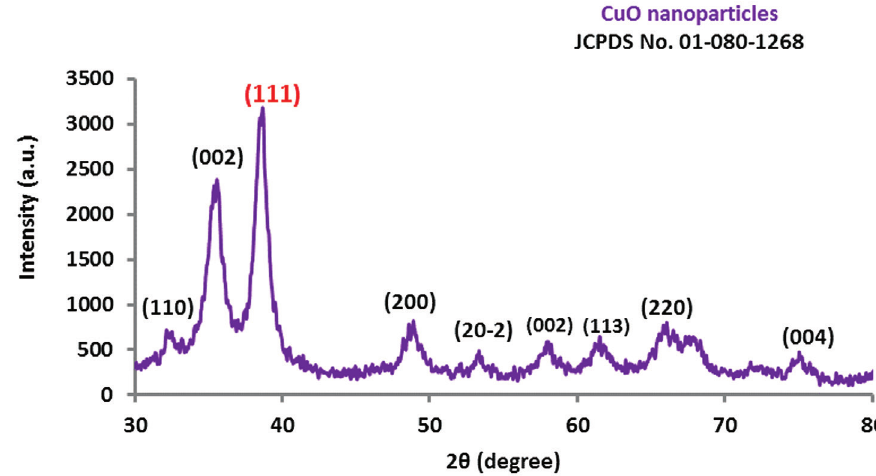
Figure 3: XRD patterns of CuO NPs synthesized by wheat extract.